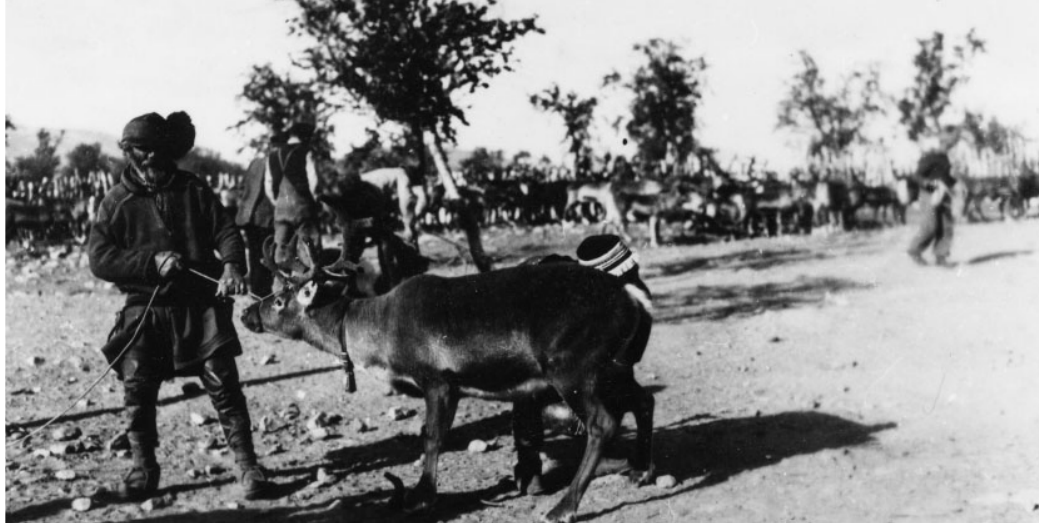
Fig. 3. Saltfjellet montains, Lønsdal, Nordland County, in the early 1900 (probably around 1920). The female reindeer, “simle”, is milked. The milk gave a delicious cheese which was a part of the traditional co-operative trade in the verdde-system between nomadic and settled people. Photo: Salten Museum,